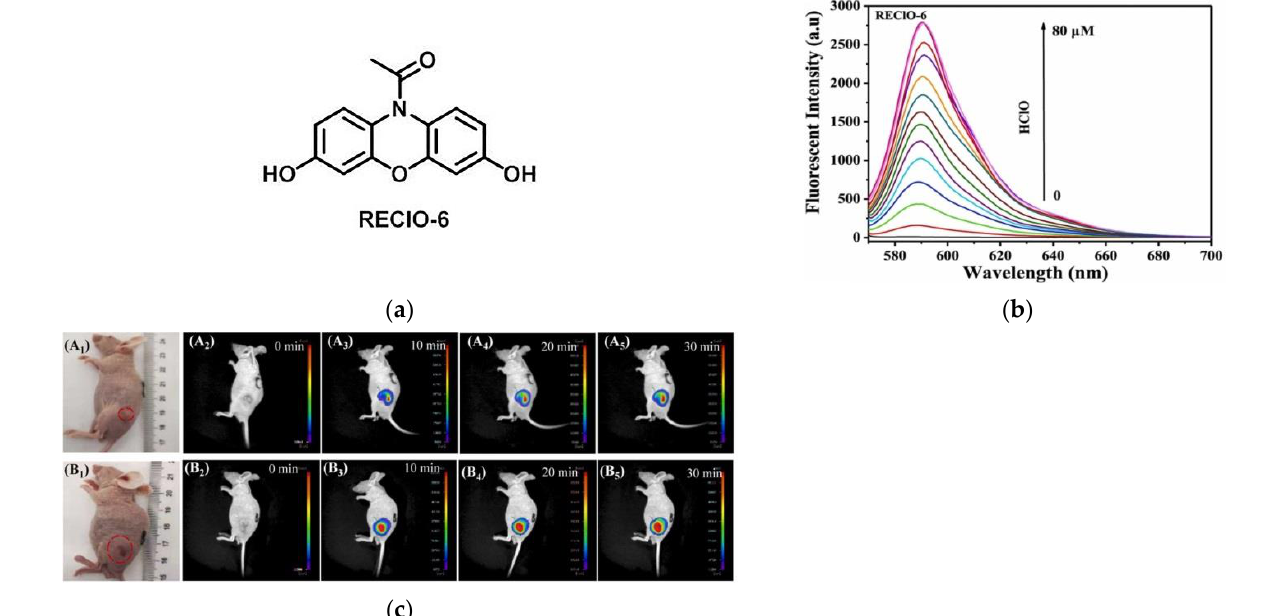
Figure 35. ( a ) The structure of probe REClO-6; ( b ) Fluorescence spectra of the probe REClO-6; ( c ) Fluorescence imaging of mice with different tumor sizes using REClO-6. Reproduced with permission from [154]. Copyright 2021 Elsevier B.V.